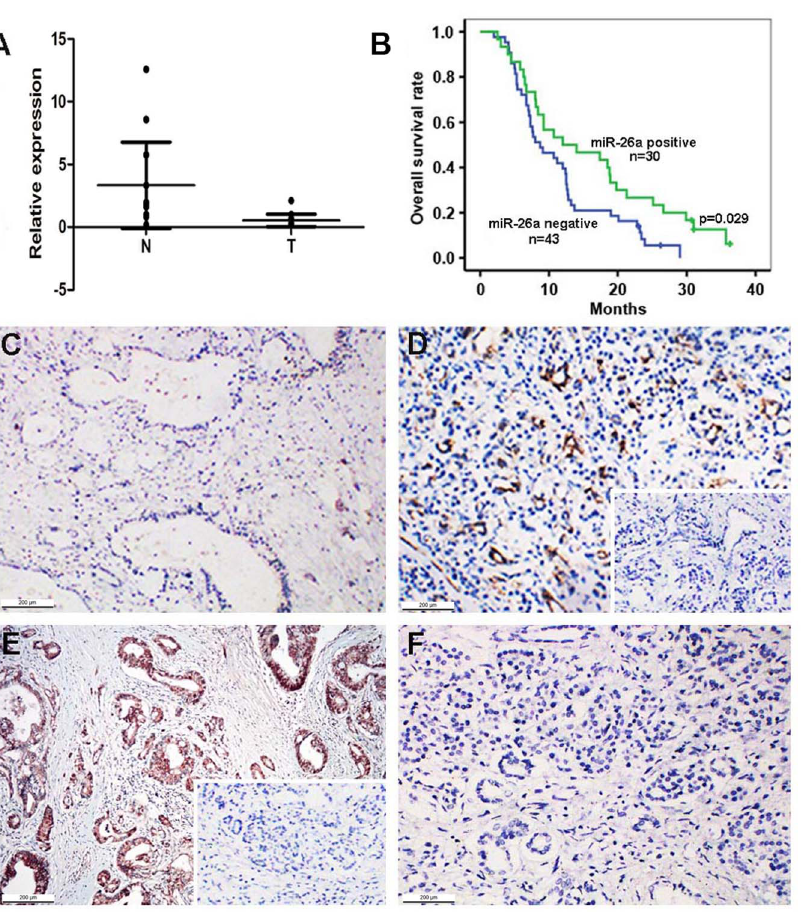
Figure 1. miR-26a expression in pancreatic cancer specimens and overall survival. (A) Average expression level of miR-26a in human PDAC specimens ( n =15) and normal pancreatic tissues ( n =15). miRNA abundance was assessed by qRT-PCR and normalized to U6 RNA. Values are presented as the mean 6 S.D. (B) Overall survival following resection of pancreatic cancer with the miR-26a-negative versus miR-26a-positive groups. The miR-26a-negative group had significantly shorter survival than the miR-26a-positive group ( P =0.029). (C,D) In situ hybridization for miR-26a in pancreatic lesions. In situ hybridization showed much lower miR-26a expression in PDAC tissues (C) than in ABPT (D). The inset shows the negative control (scrambled sequence probe). Cytoplasmic staining in the ductal epithelial cells stands in contrast with the negative staining with the scrambled probe. (E,F) In situ hybridization for miR-21 (positive control) in pancreatic lesions. In situ hybridization showed much stronger miR-21 expression in PDAC tissues (E) than in ABPT (F). The inset shows the negative control (scrambled sequence probe). Cytoplasmic staining in tumor cells stands in contrast with the negative staining of the scrambled probe. Original magnification, 100 6 .